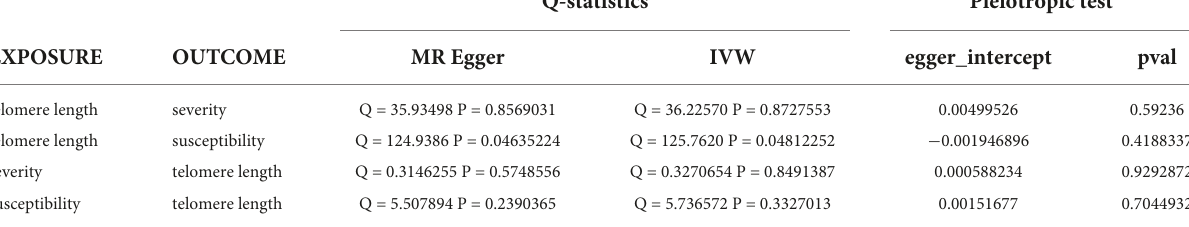
TABLE 3 Heterogeneity and pleiotropic tests for telomere length and susceptibility and severity of